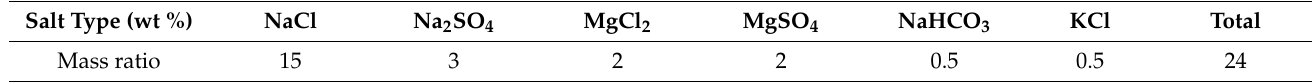
Table 4. Mix of the test solution.